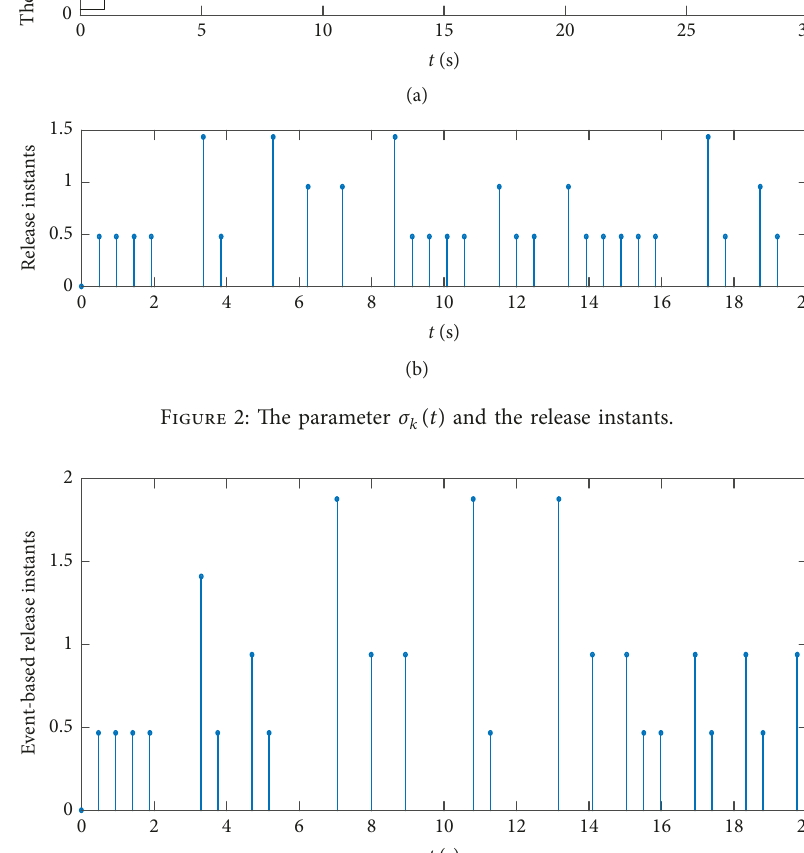
Figure 3: The release instants and release intervals of the improved static